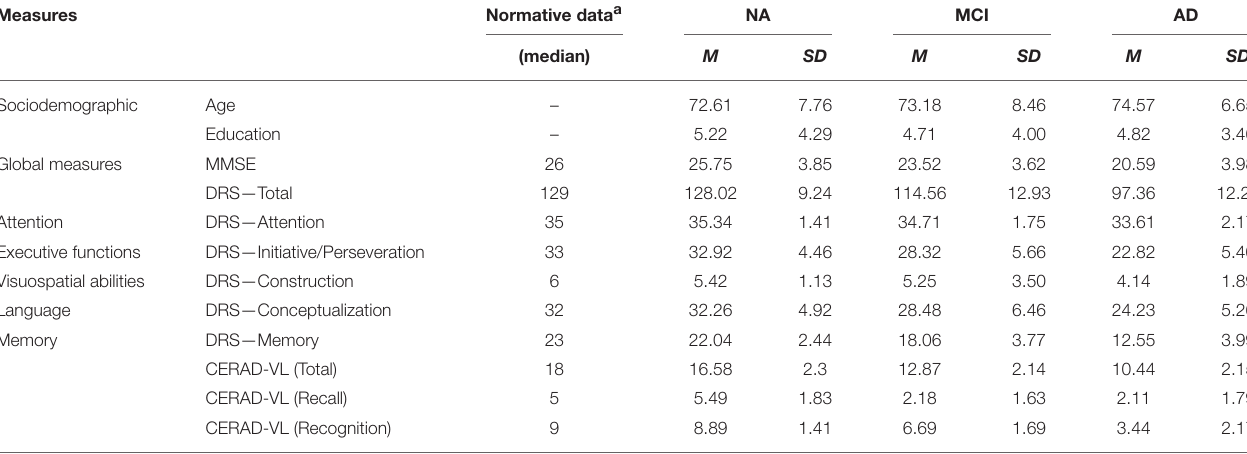
TABLE 1 | Participant’s description in sociodemographic and cognitive measures used for diagnosis.